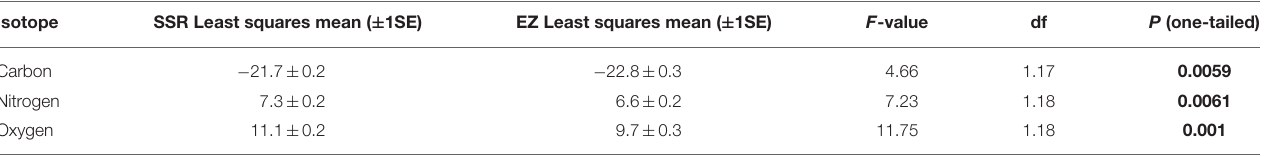
TABLE 2 | General linear mixed model results for forest comparisons.